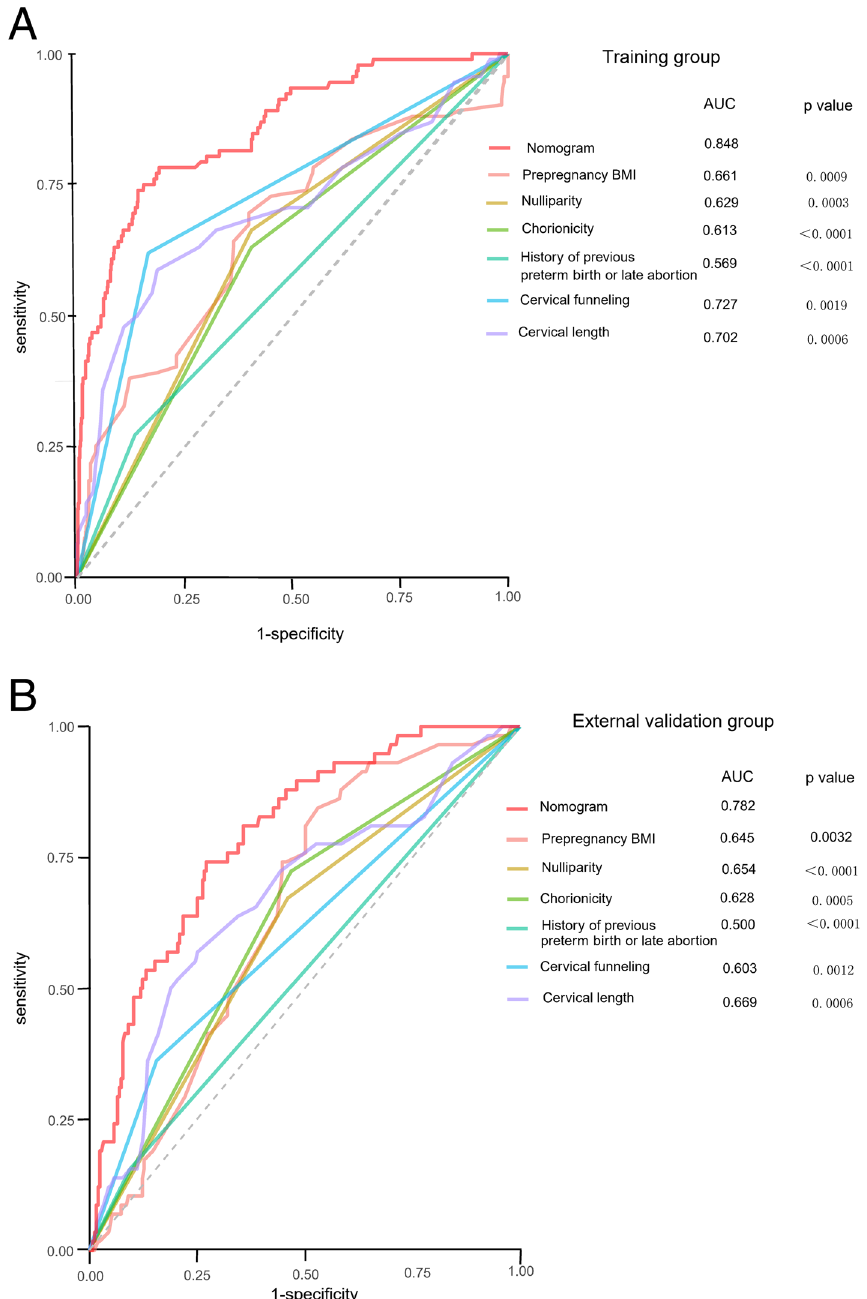
Figure 7. Validation of the predictive accuracy of the nomogram and six individual predictors. ROC curves and AUCs were used to assess the predictive accuracy of the nomogram compared with either meaningful variable (prepregnancy BMI, nulliparity, chorionicity, previous preterm birth or late abortion, cervical funnelling, cervical length). P values show the AUC for the nomogram versus the AUC for other variables alone. AUC area under the curve, ROC receiver operating